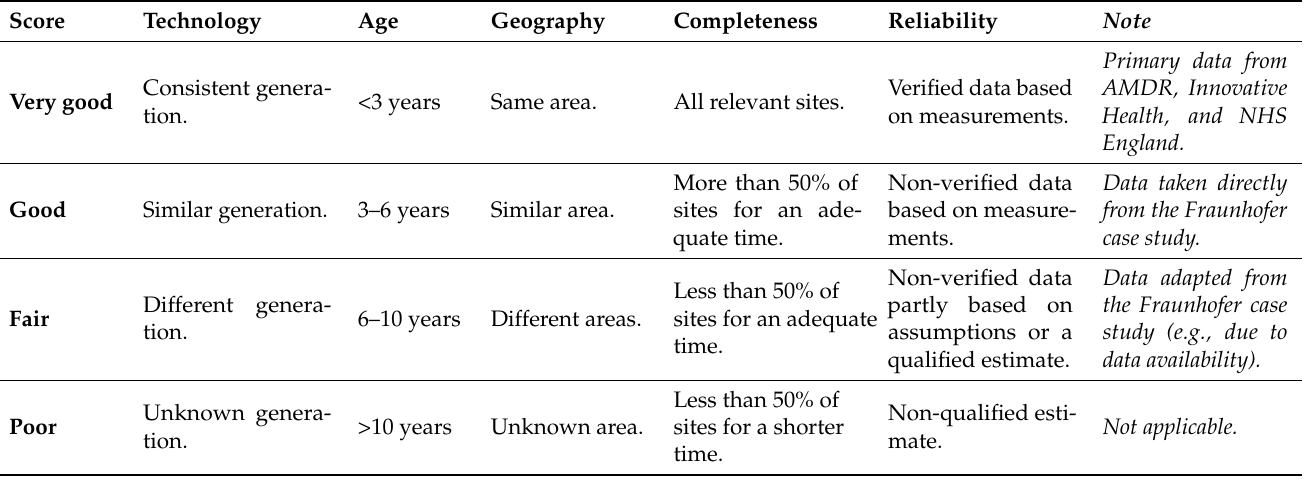
Table 2. Qualitative data quality appraisal rubric. Adjusted from the NHS guideline for accounting and reporting medical device life cycles